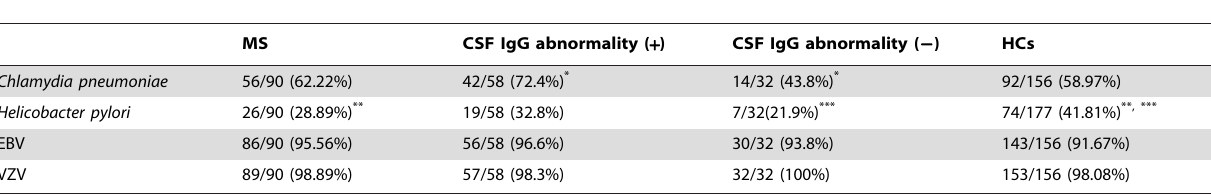
Table 3. Comparisons of the frequencies of antibodies against common infectious